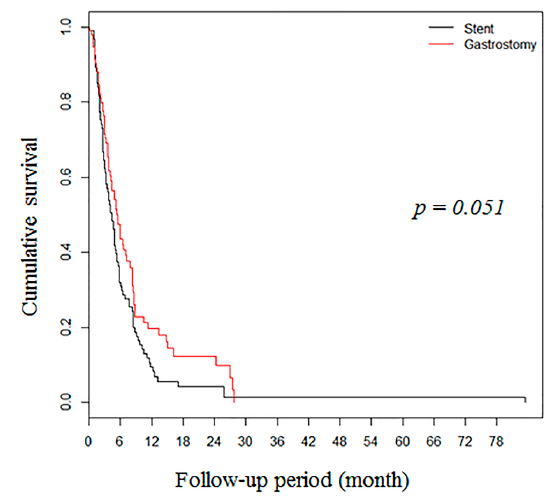
Figure 3. Kaplan–Meier survival curves showing overall survival rates in the propensity score-matched cohort (94 matched pairs) with patients with malignant esophageal obstruction after gastrostomy and stent insertion.